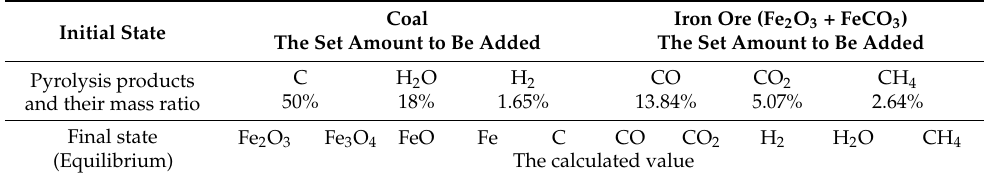
Table 4. The composition of the reduction thermodynamic system.